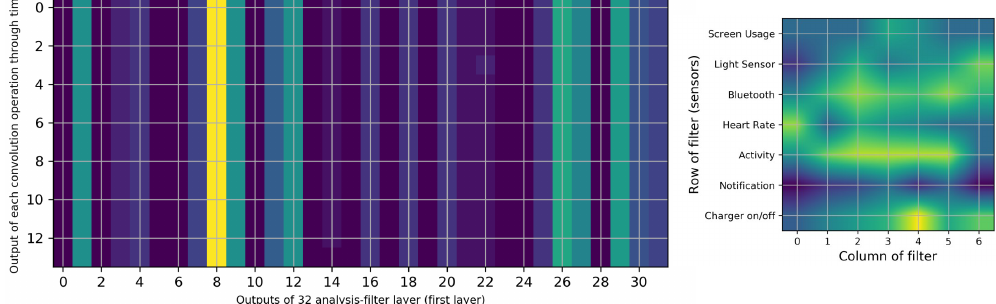
Figure 8. The average of 300 outputs of analysis-filter layers ( left ) and heat map of filter number 8 ( right ).